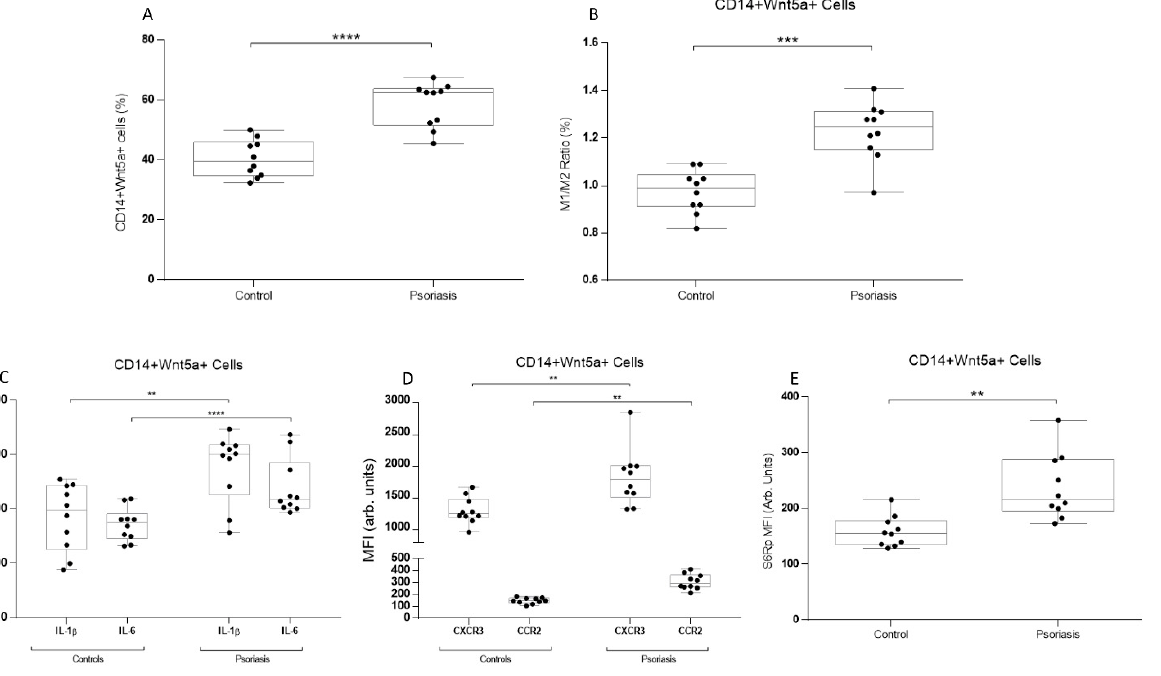
Figure 1. Monocyte phenotype, intracellular cytokines, and chemokine levels in CD14+Wnt5a+ cells from psoriatic patients and healthy subjects. ( A ) Frequency of CD14+Wnt5a+ cells in psoriatic patients and healthy subjects. ( B ) M1 (CD14+HLA-DR+CCR2+) monocytes phenotype and/M2 (CD14+CD163+CCR2-) monocytes phenotype ratio in CD14+Wnt5a+ cells from psoriatic patients and healthy subjects. ( C ) IL-1 β and IL-6 intracellular MFI levels in CD14+Wnt5a+ cells. ( D ) CXCR3 and CCR2 intracellular MFI levels in CD14+Wnt5a+ cells. ( E ) mTOR activity marker phosphorylated S6R intracellular MFI levels in psoriatic and healthy subjects. ( A ) **** p = 0.0001; ( B ) *** p = 0.0006; ( C ) ** p = 0.002, **** p = 0.0001; ( D ) ** p = 0.0032; and ( E ) ** p = 0.0044. The Mann–Whitney test was